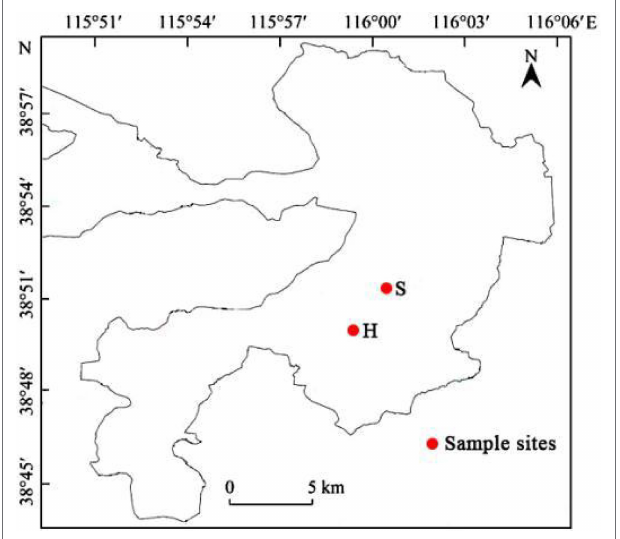
FIGURE 1 | Map of the sampling sites in Baiyangdian